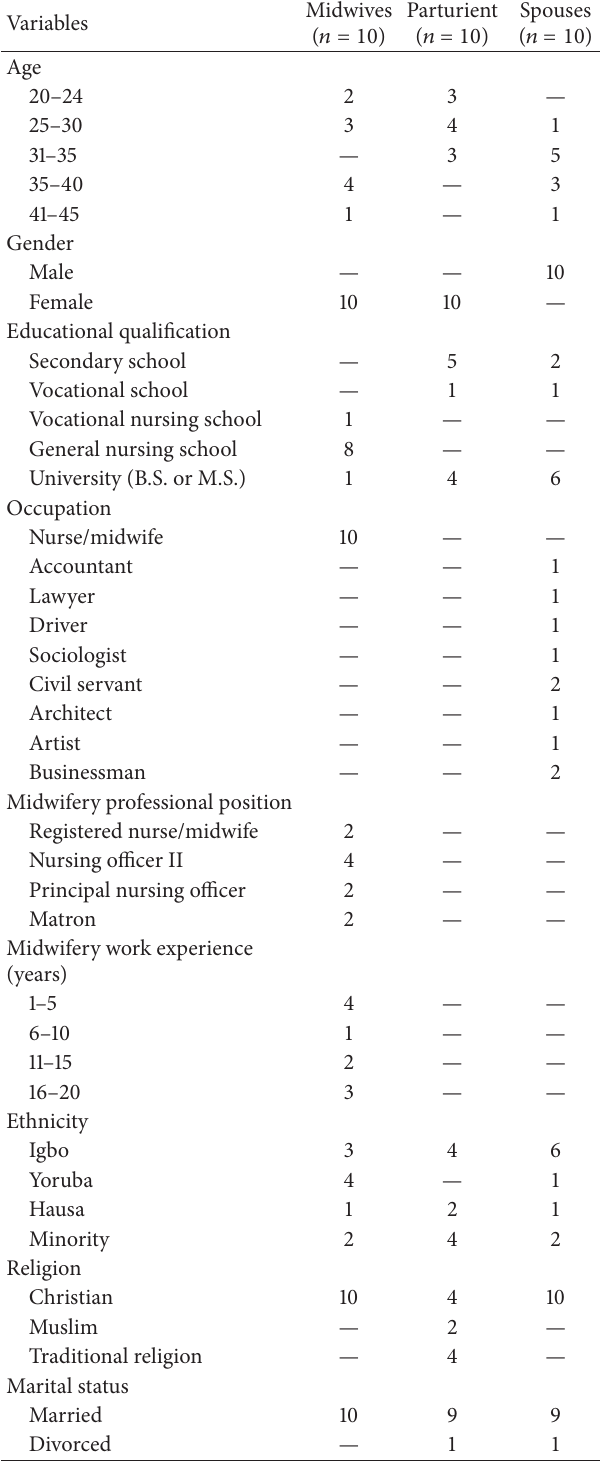
Table 2: Characteristics of participants.